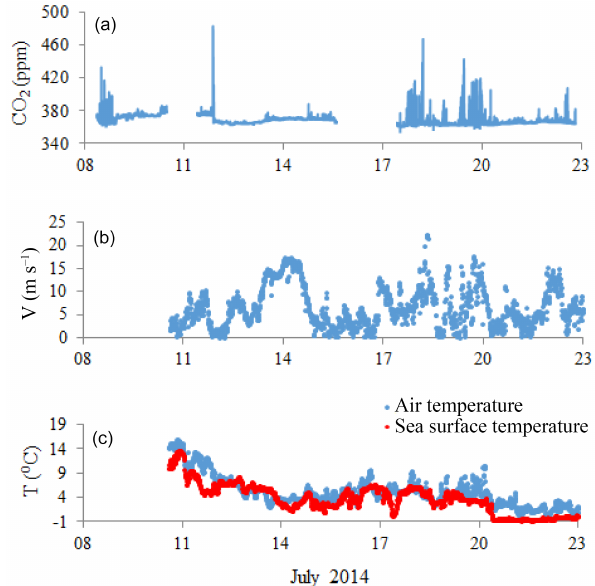
Figure 2. Panel (a) : CO 2 mixing ratio (ppm); panel (b) : wind speed (ms − 1 ); panel (c) : sea surface and air temperatures ( ◦ C). CO 2 mea- surements were not reported from 10:30 on 10 July to 09:00